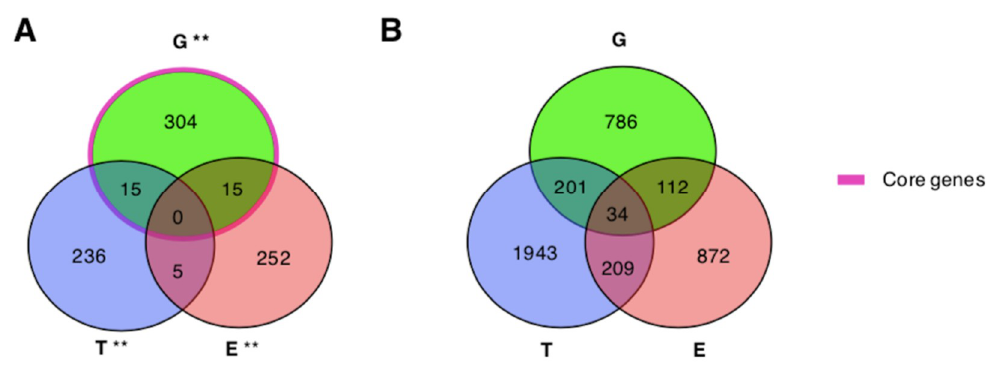
Figure 2. Overlaps among genes associated with ASDs by genomics, epigenomics, and transcriptomics. G: Genomics; E: Epigenomics; T: Transcriptomics. ** major.